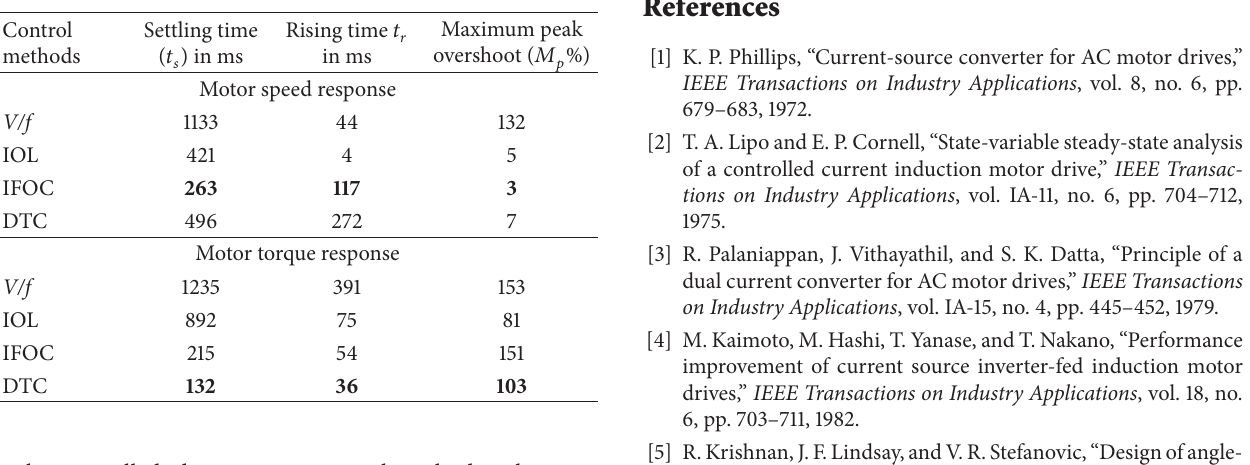
Table 3: Transient Response results for Step change in Torque reference